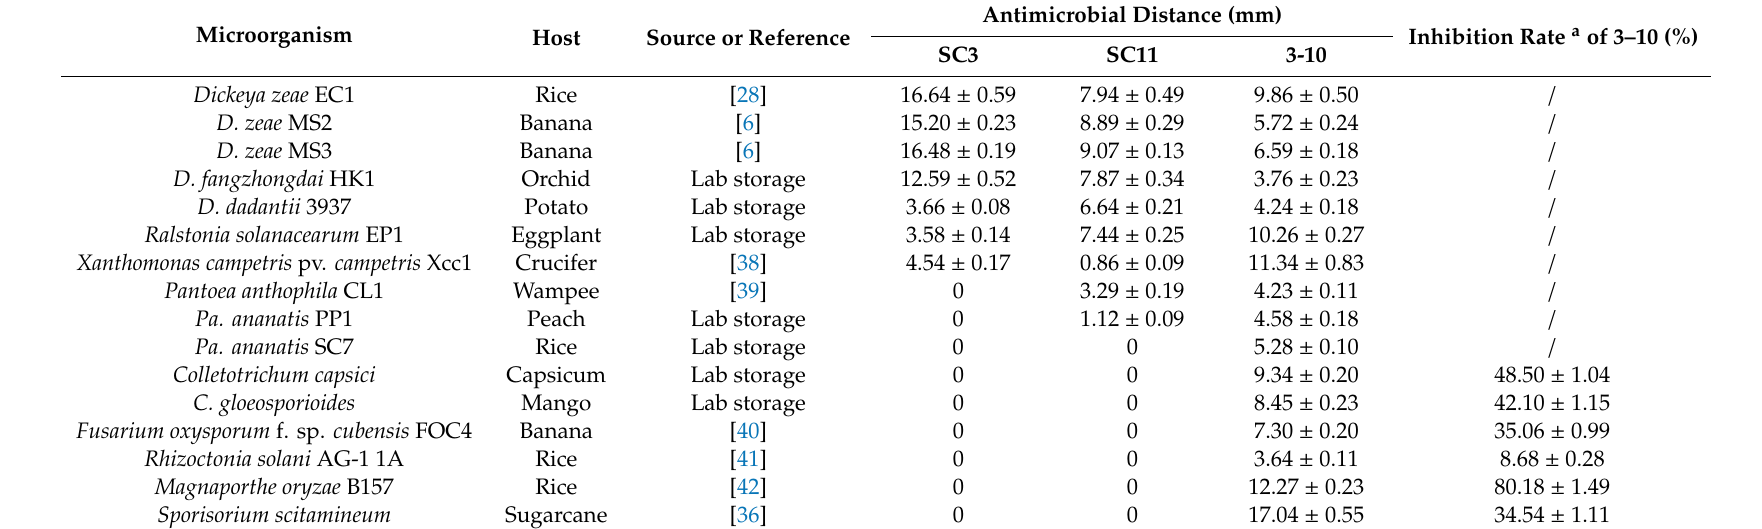
Table 1. Antimicrobial distances of antagonistic bacterial strains against some pathogenic